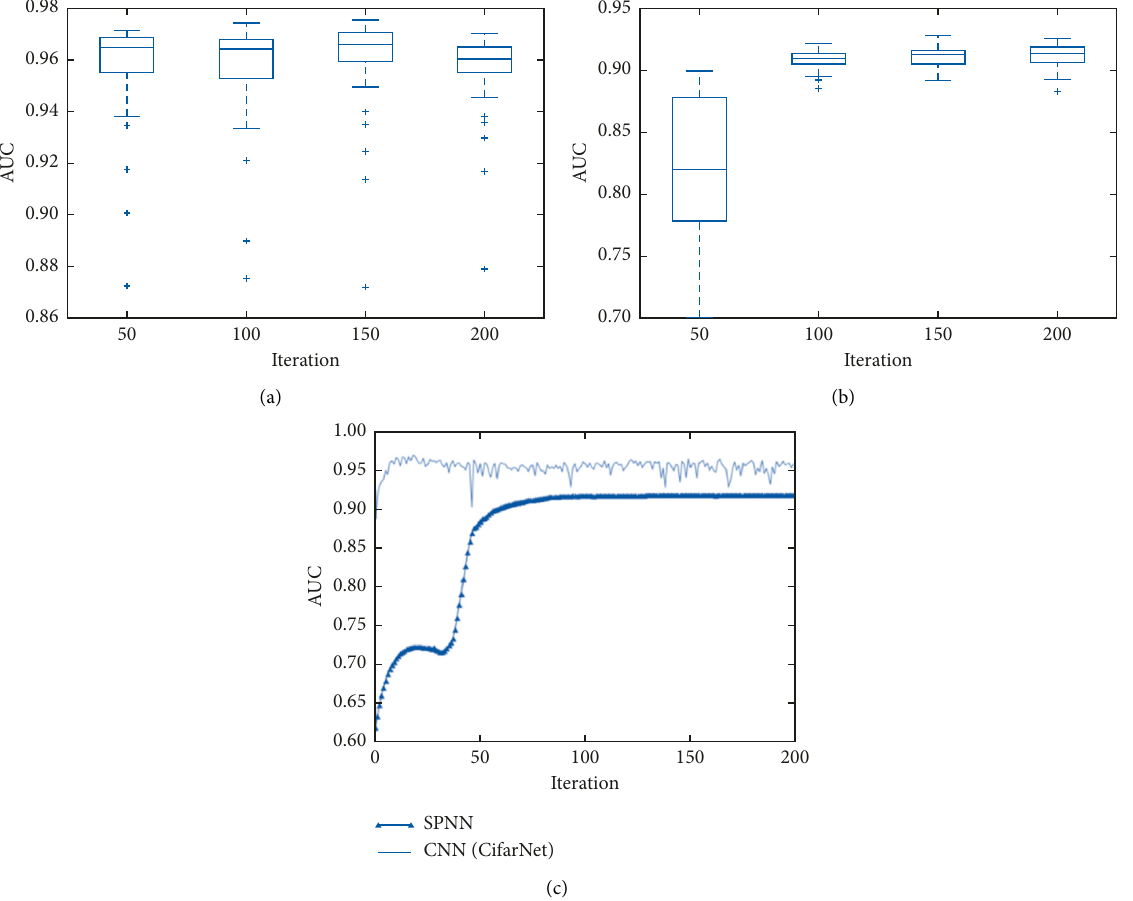
Figure 5: (a) CNN convergence analysis (CifarNet). (b) SPNN convergence analysis. (c) Comparison of the SPNN convergence with the CNN